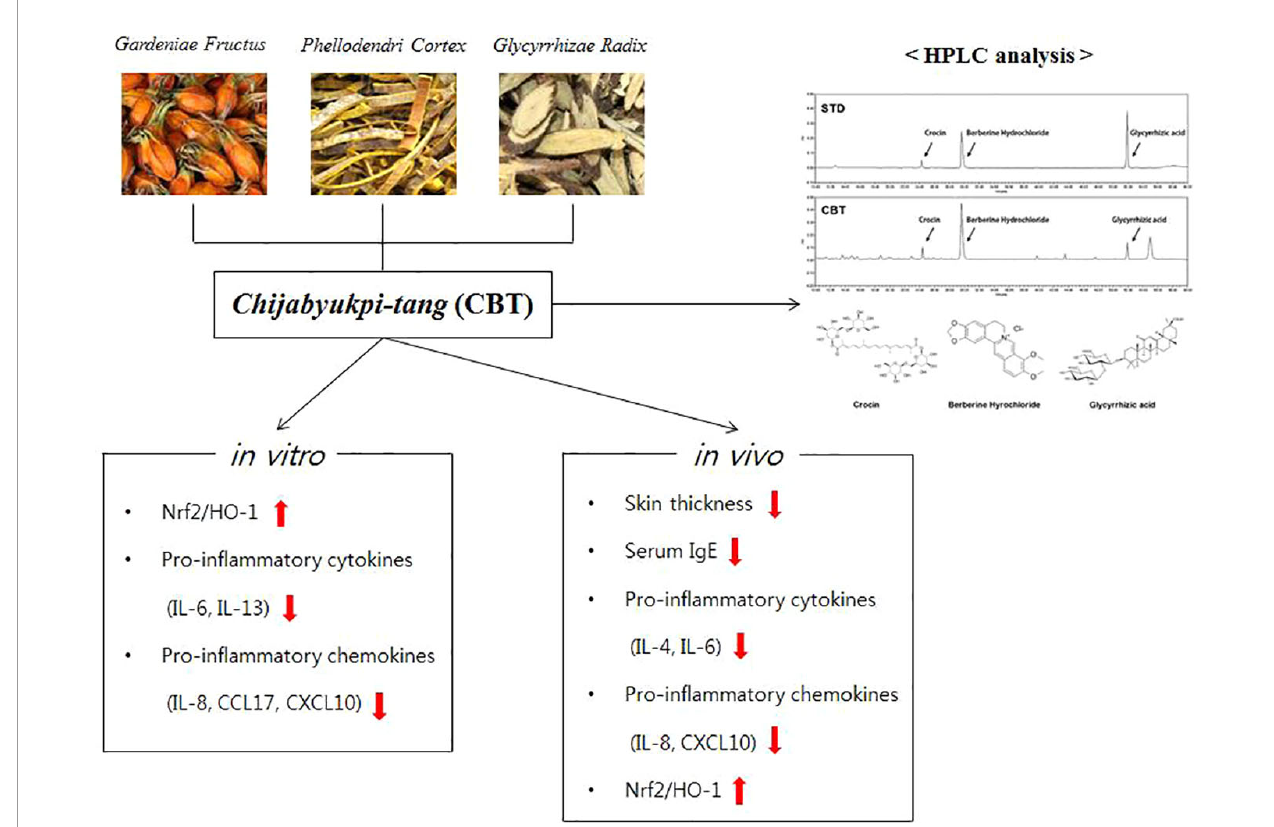
FIGURE 7 | A graphic summary of atopic dermatitis (AD)-like symptoms and related genes regulated by Chijabyukpi-tang